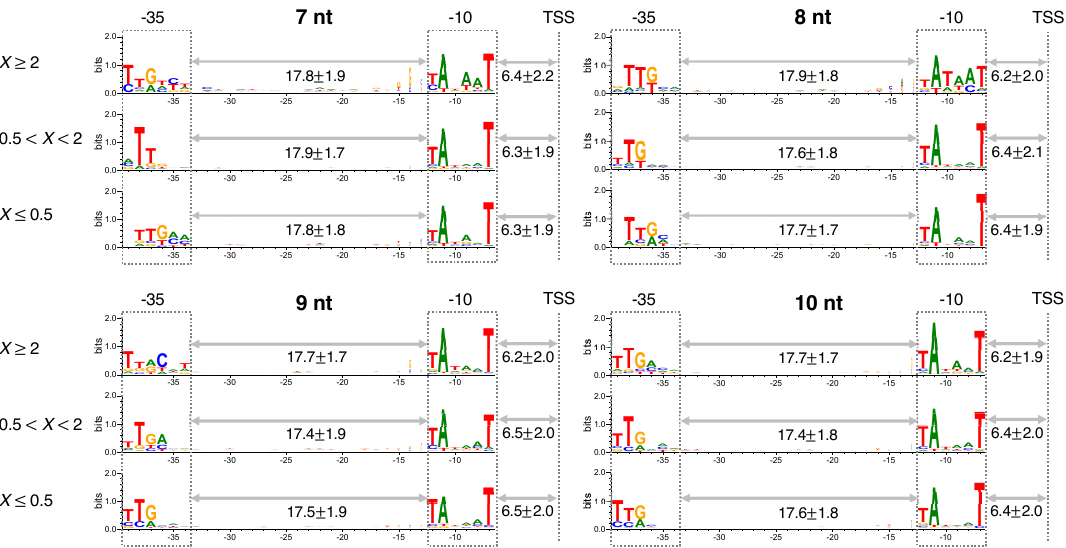
Figure 4. The consensus − 10 and − 35 motifs that are detected by considering variable spacer lengths. We used the same classification of the three promoter groups ( X ≥ 2, 0.5 < X < 2 and X ≤ 0.5) and initiation complexes having 7–10 nt nascent RNAs, as the classification described in the legend of Figure 3. The bipartite motif search in σ 70 promoter regions ( − 40 to − 1, where + 1 is TSS) were performed by Dipartite program [42] (see Figure 3 for the number of samples n in each group), in which the range of the spacer length between − 10 and 35 motifs (both 6 bases) was defined as 15 to 21 bases. In order to find best motifs, the search process was repeated fifty times. The − 10 / − 35 motifs and TSS are shown by boxes and lines, respectively. Sequence Logos represent the alignments with gaps to make uniform 21-base spacers between − 10 and − 35 motifs. The actual distributed lengths of the spacers between − 10 and − 35 motifs, and between − 10 motif and TSS are shown as the average values ± standard deviations, together with gray arrows. The promoter sequences that were aligned to have the ≥ 20-nt long spacer between − 10 motif and TSS were removed from the measured values of the spacer lengths, since such situations are structurally unlikely